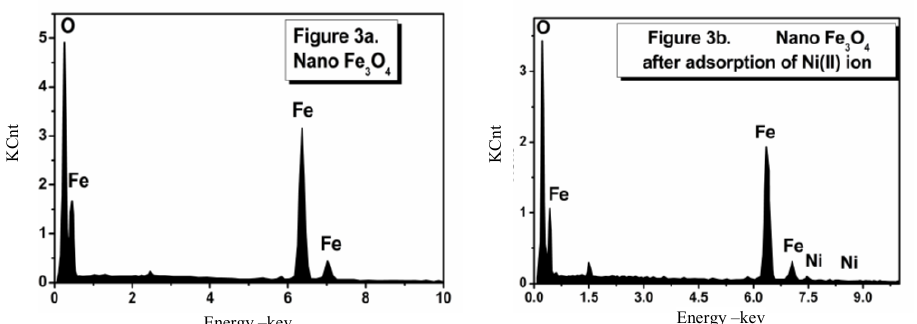
Figure 3. EDAX for a) Synthetic nano Fe (SNIO) after adsorption of Ni(II)